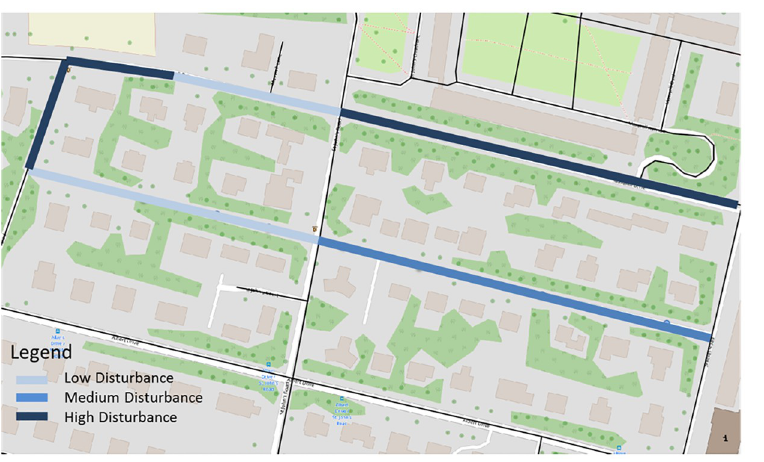
Fig 5. The visualisation of Index of disturbance calculates per each road